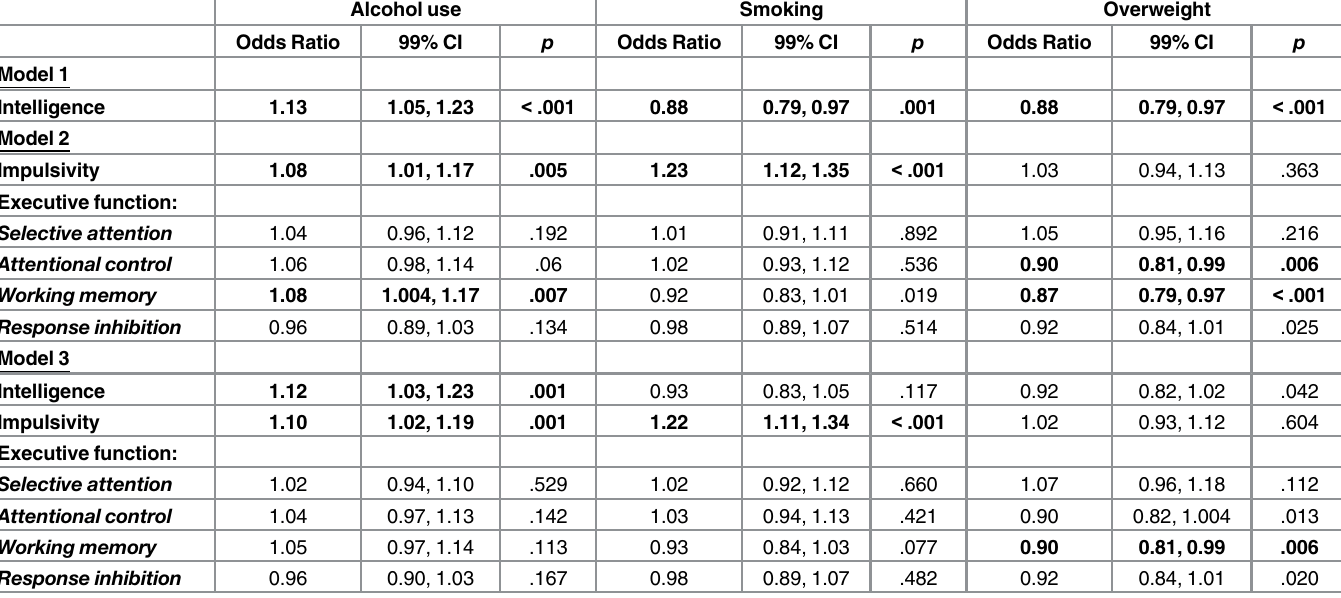
Table 5 displays the p values of Wald tests comparing Model 3 (full model with intelligence, executive function, and impulsivity included) with both Model 1 (intelligence only) and Model 2 (executive function and impulsivity only). The full models, containing all cognitive variables, showed improved fit over models containing only intelligence for all outcome variables except physical activity. Table 6 presents the results of models predicting alcohol use, smoking, and overweight. Table 7 presents the results of models predicting fruit and vegetable consumption and physical activity. Comparison of models that included or excluded socioeconomic variables indicated Table 6. Logistic regressions predicting alcohol use, smoking, and overweight at age 13. Alcohol